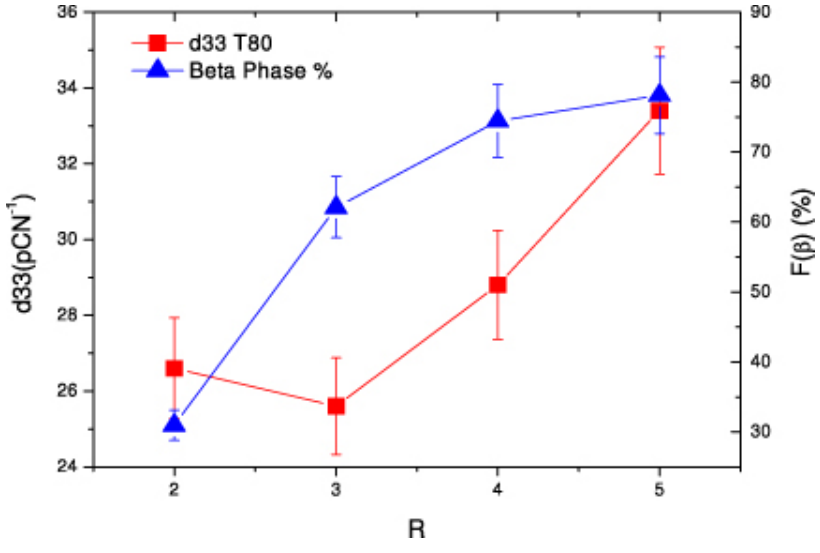
Figure 8. d 33 and F(β) (%) for samples depending on stretching ratios R at 80 °C [100].